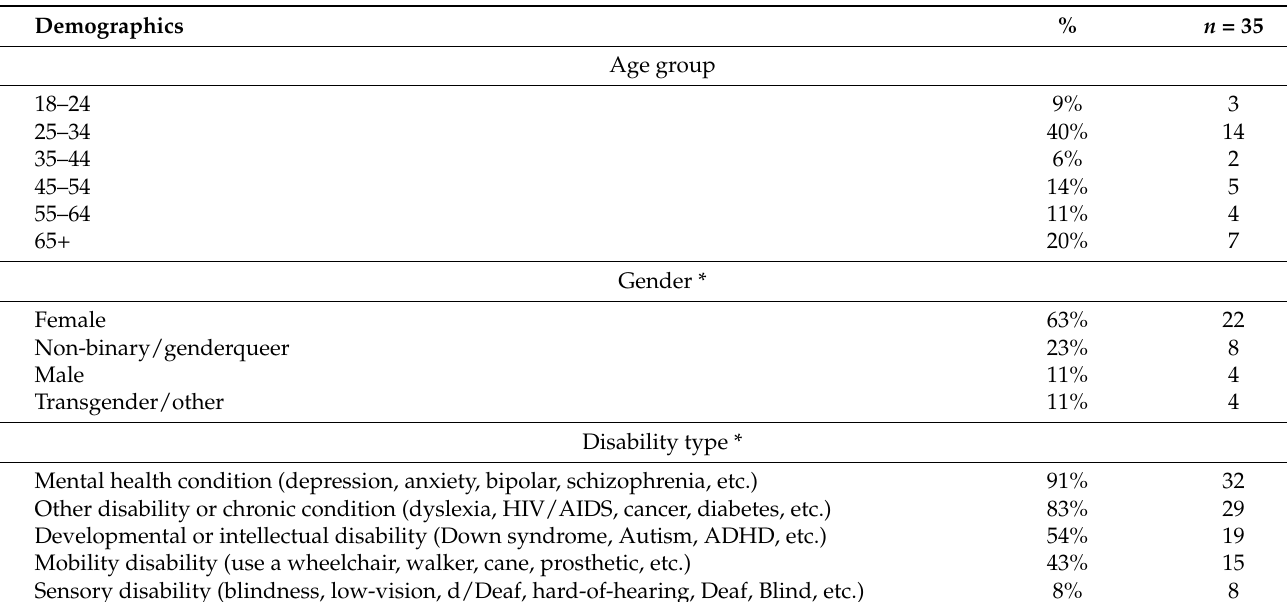
Table 2. Phase II participant